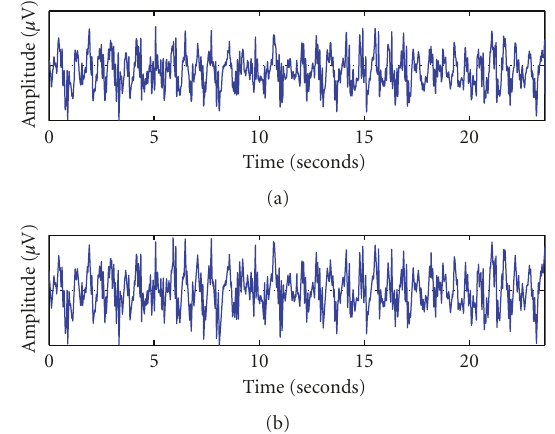
Figure 13: A comparison between (a) an original EEG signal and (b) the reconstructed EEG signal. 2 K = 1184, CR = 81 . 48%, CC =